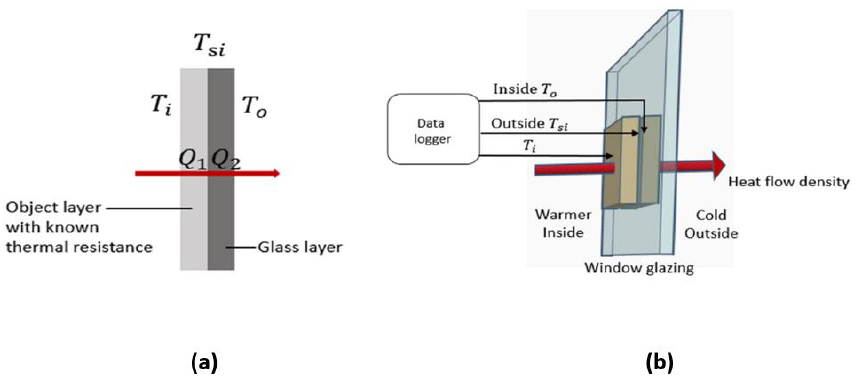
Figure 15. ( a ) Heat transfer through the multi-layered surfaces; ( b ) The measurement setup for the instrument. Reproduced from Feng et al. [39].